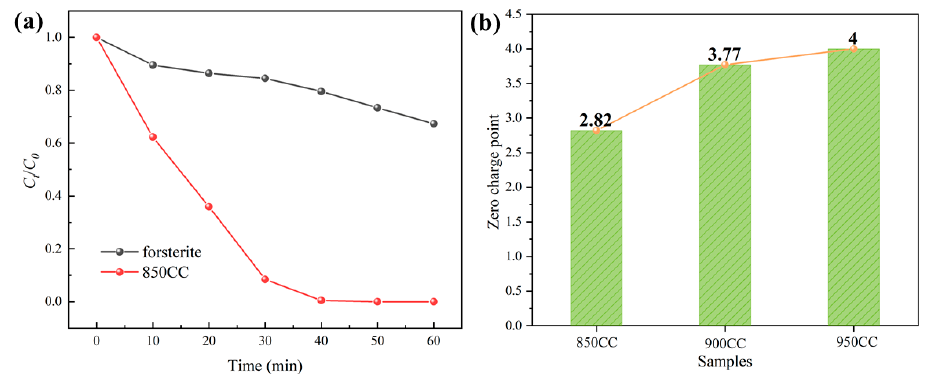
Figure 10. The comparison of catalytic performance between 850CC and natural forsterite ( a ) and point of zero charge of 850CC, 900CC and 950CC ( b ).